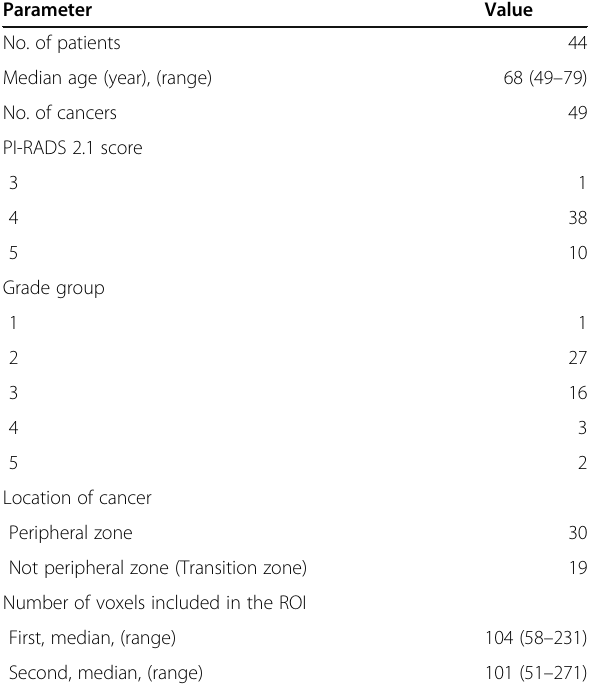
Table 1 Summary of patient and lesion